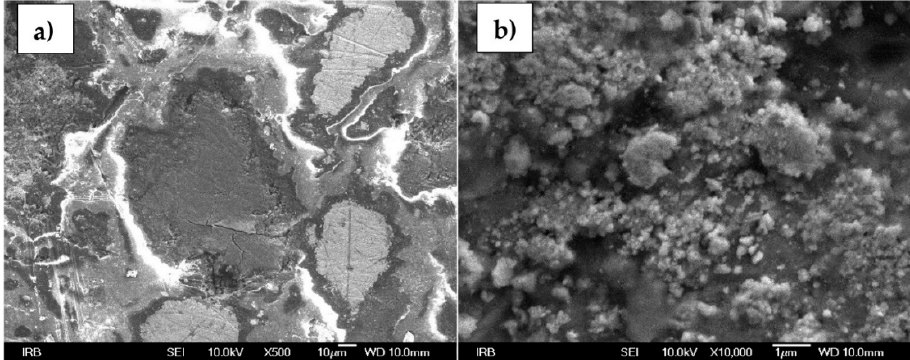
Figure 17. SEM images of MN1 membrane surface at a ( a ) 500× and ( b ) 10,000×